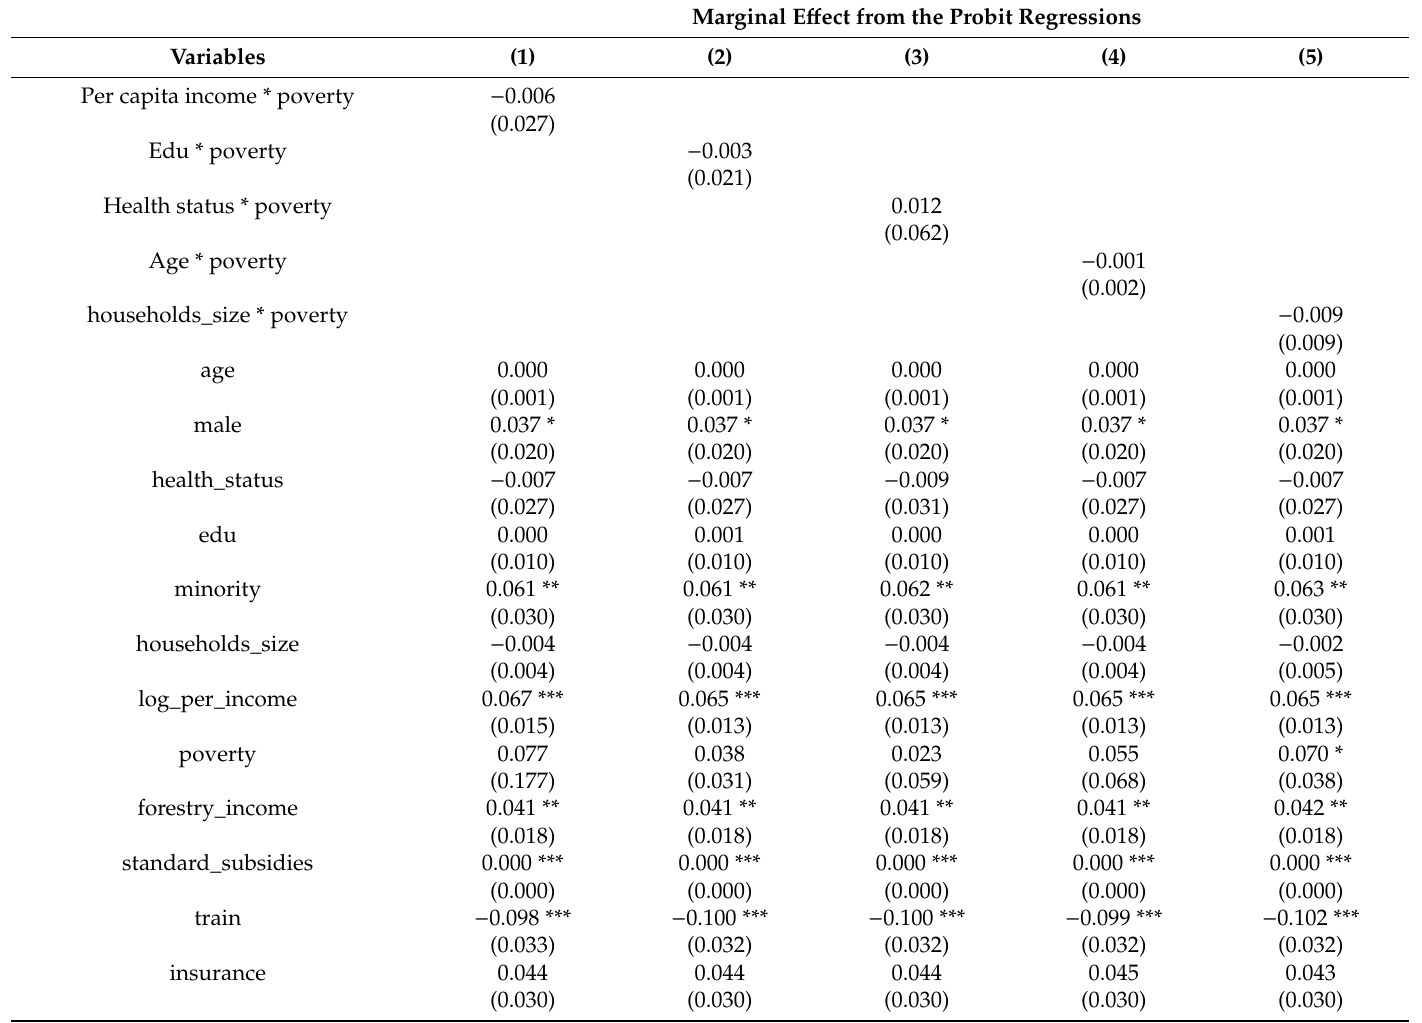
Table 10. The influencing factors of the re-employment behavior of EFRs (heterogeneity